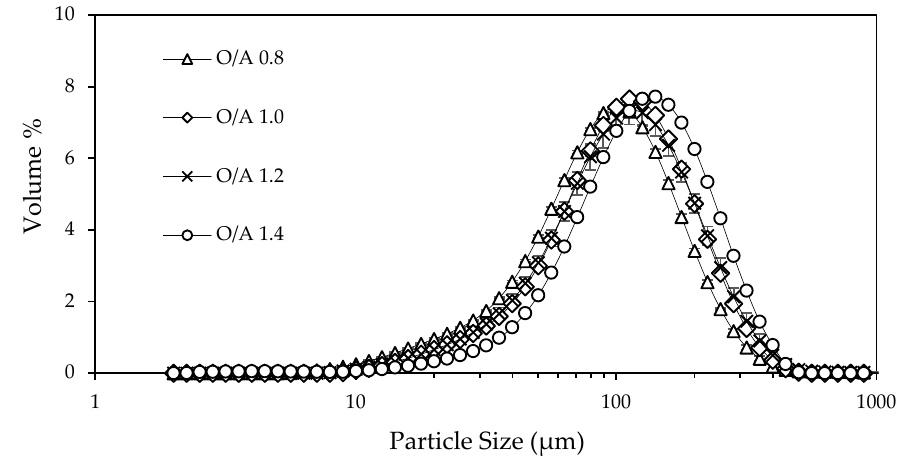
Figure 4. Effect of varying the O/A ratios on the PSD of Nd 2 (SO 4 ) 3 .8 H 2 O. The peaks of the PSDs in Figure 4 shifted to the right as the O/A ratio increased from 0.8 to 1.4. This showed that increasing the amount of ethanol (i.e., O/A ratio from 0.8 to 1.4) increased particle sizes. However, the increase in the particle sizes, when the O/A ratio was increased from 1.0 to 1.2, was insignificant. This behaviour can be attributed to